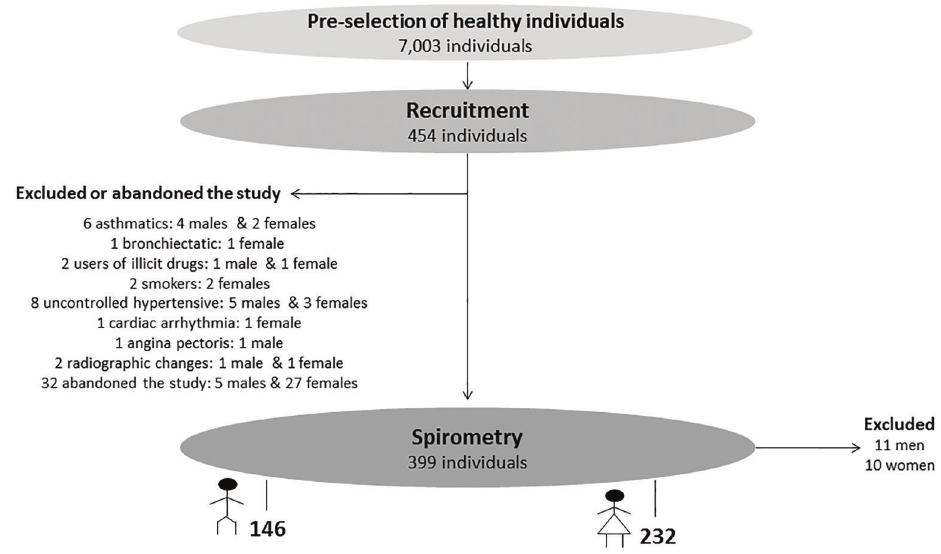
Figure 1. Patient recruitment fl owchart. A total of 16.73% excluded or abandoned the study (12.11% during the test stage, 4.62% during spirometry); a total of 83.27% completed all